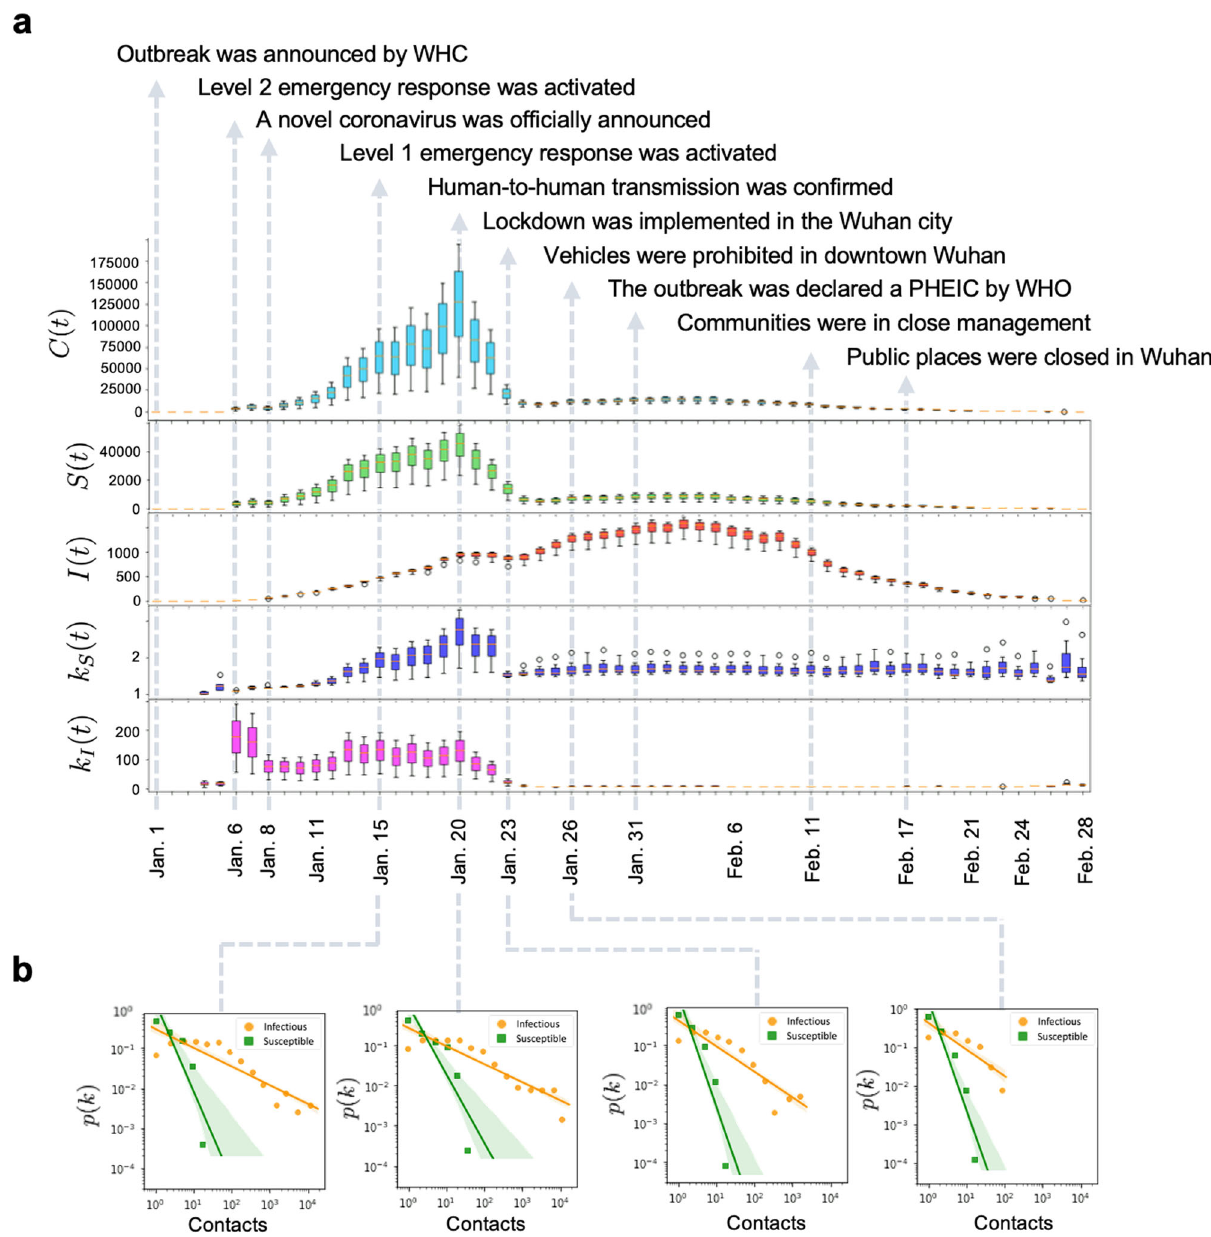
Fig. 2 Daily characteristics of fi ve indicators. a C ( t ), the daily total number of contacts between infectious and contacted individuals. S ( t ), the daily total number of contacted individuals who had encountered the infectious at least once. I ( t ), the daily total number of infectious individuals who had encountered with contacted individuals at least once. k S ( t ), the daily average number of infectious individuals that each susceptible individual encountered. k I ( t ), the daily average number of susceptible individuals that each infectious individual contacted. The error bar in this panel indicates the standard deviation of different time interval T in the contact model, which varies from 15 to 120 min. b The distributions p ( k ) of the daily number ( k ) of contacts by all contacted individuals and the distributions p ( k ) of the daily number ( k ) of contacts by all con fi rmed cases, respectively, on four speci fi c